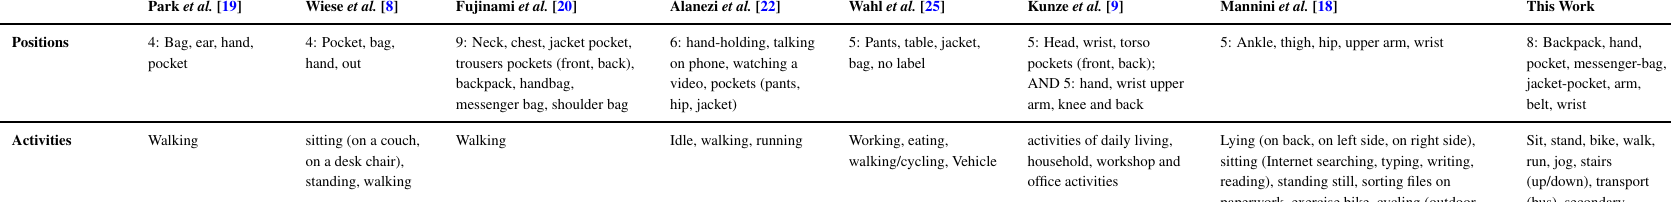
Table 16. Comparison with other accelerometer-based phone placement solutions. LOSO, leave-one-subject-out. Park etal. [19]